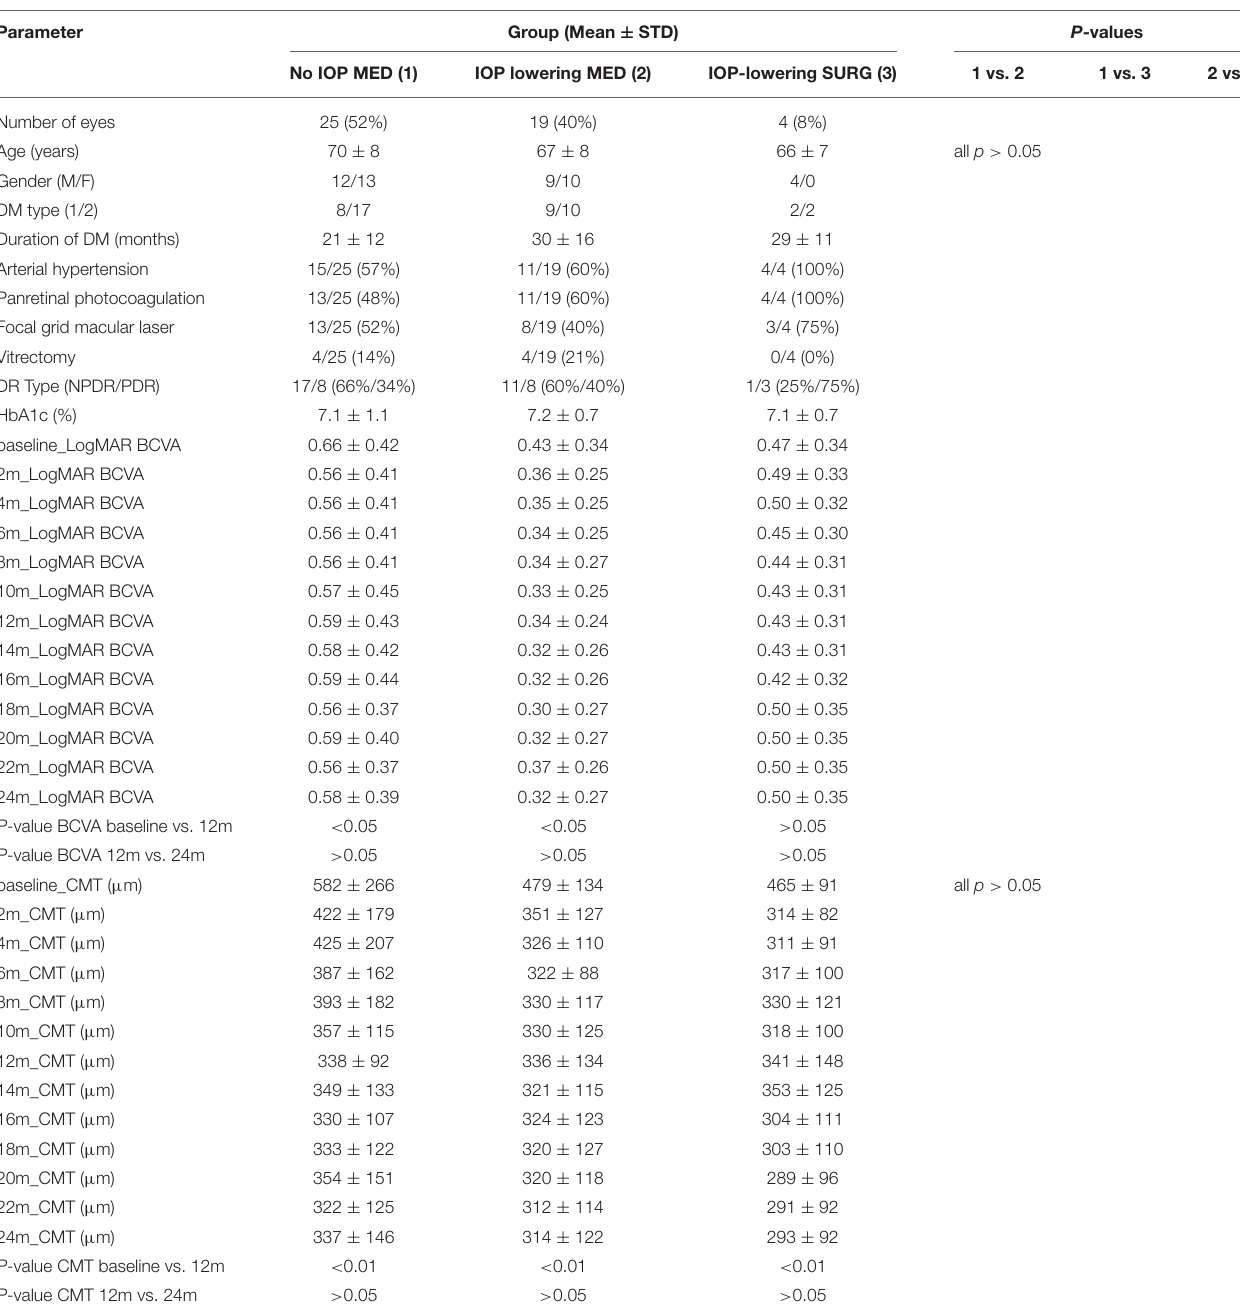
TABLE 2 | Clinical and imaging data of the subgroup analysis.